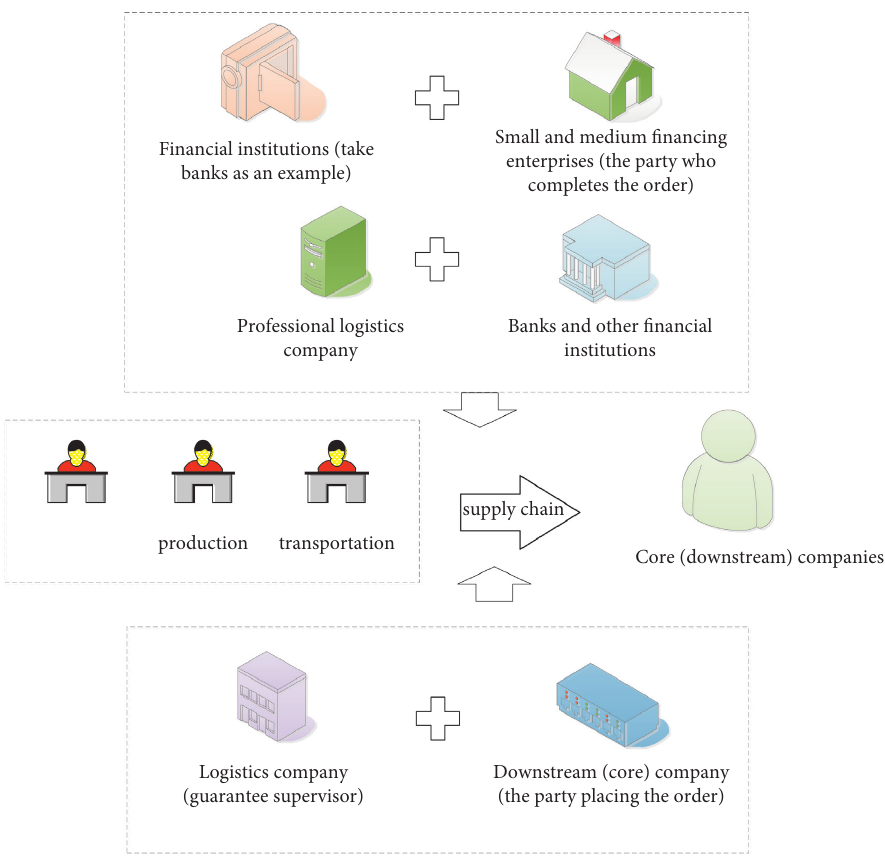
Figure 3: Risk control chart of order financing Table 1: Preliminary indicators for order financing risk evaluation.